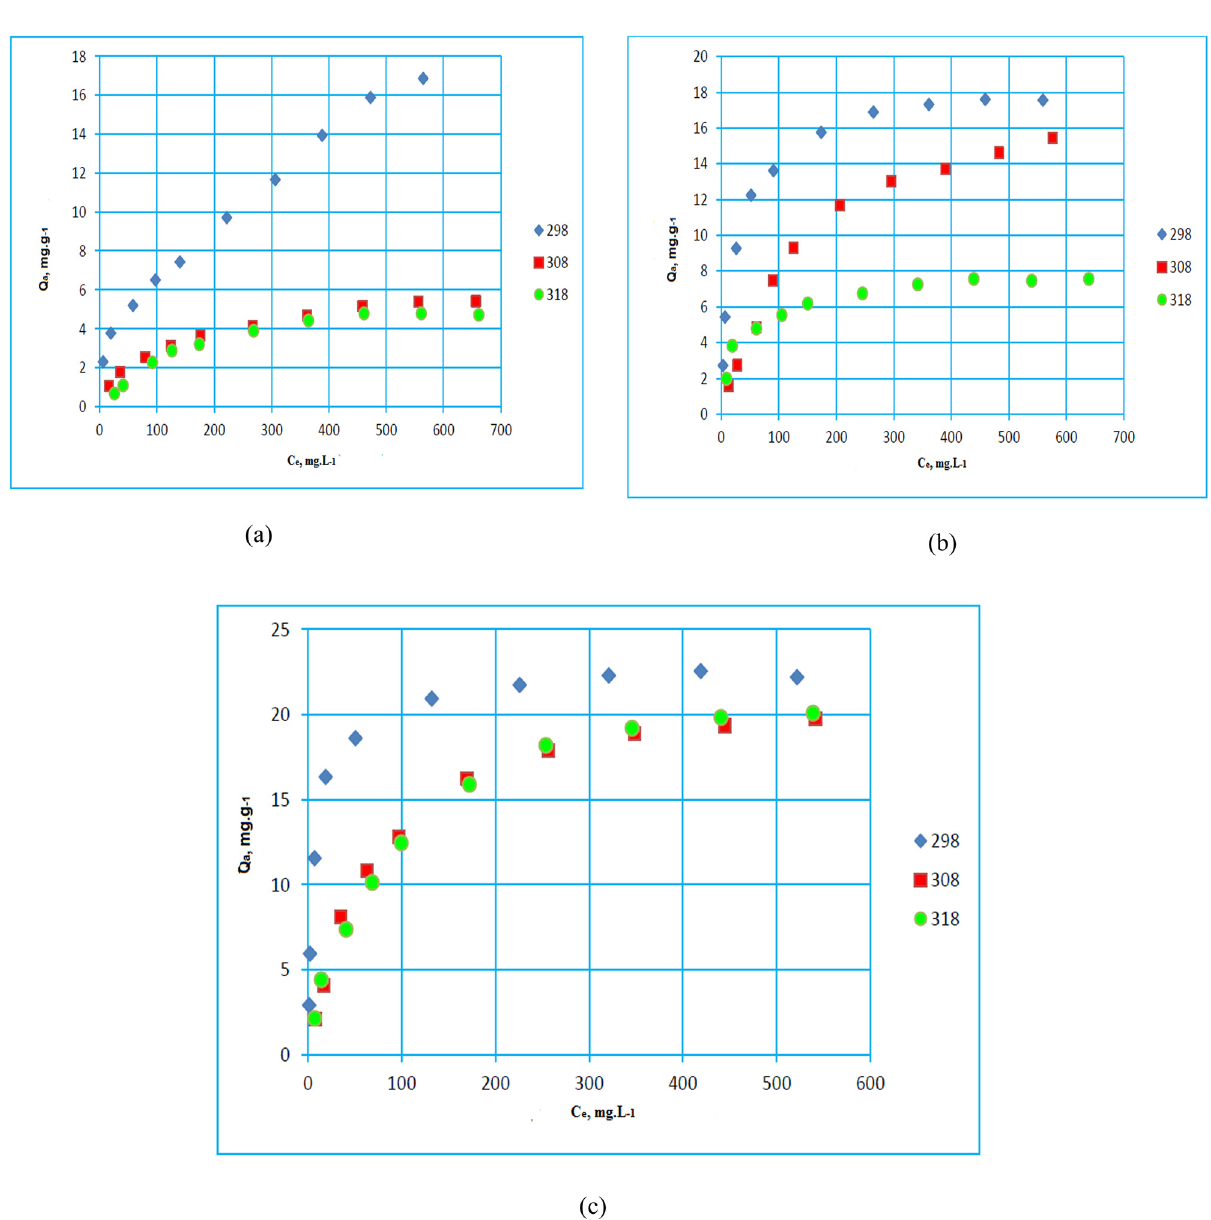
Figure 8: Paracetamol adsorption isotherm on GM1 ( a ) , GM2 ( b ) , and GM3 ( c ) at di ff erent